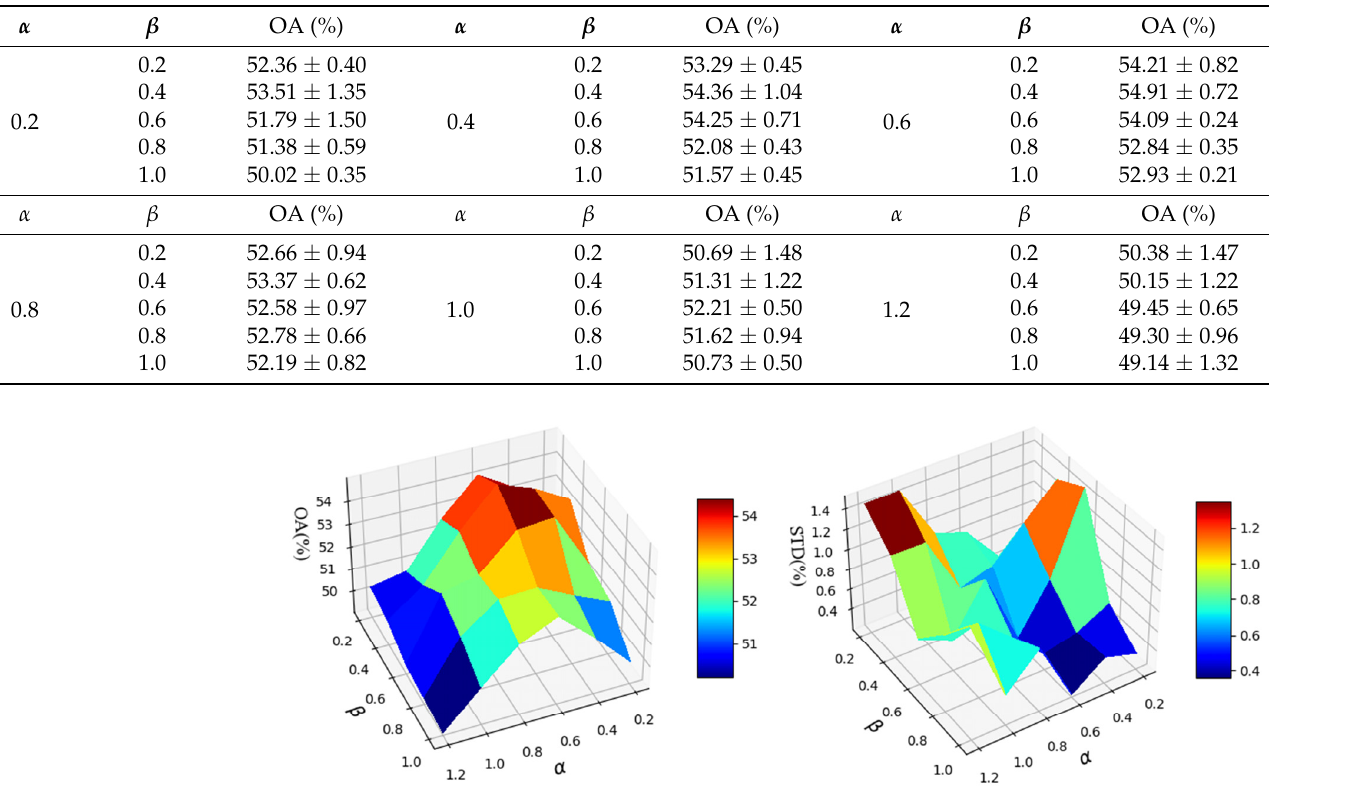
Table 8. Parametric analysis experiments using the long-tailed SIRI-WHU dataset with the imbalance ratio of 0.02.